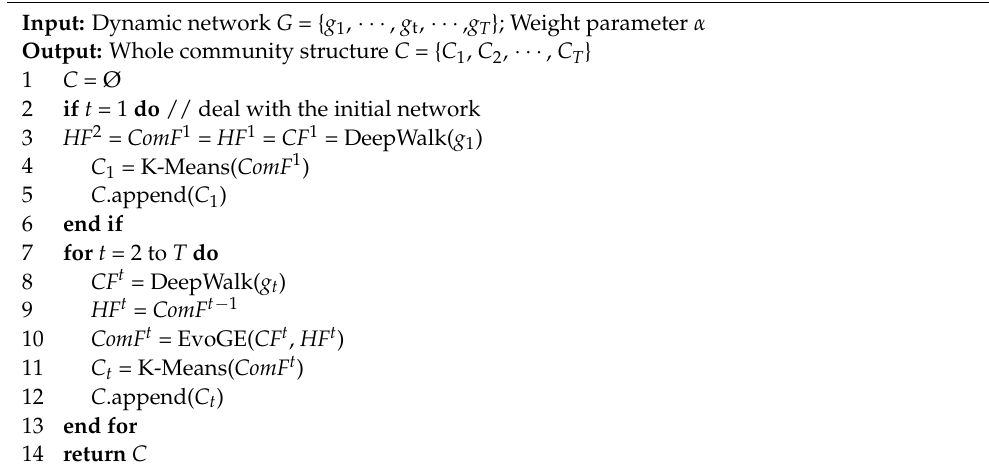
Algorithm 2: Dynamic community detection framework based on EDW